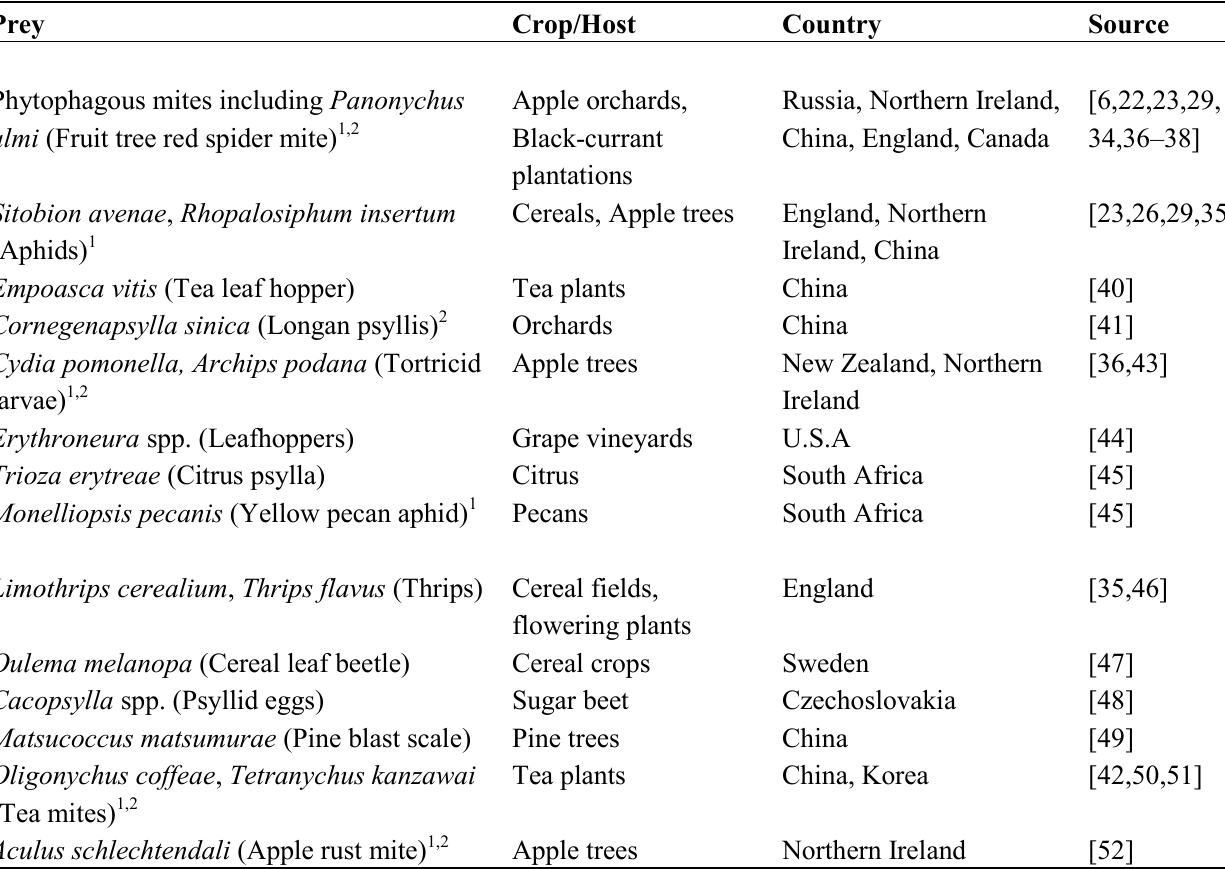
Table 2. References to Anystis baccarum feeding on invertebrate pest species.